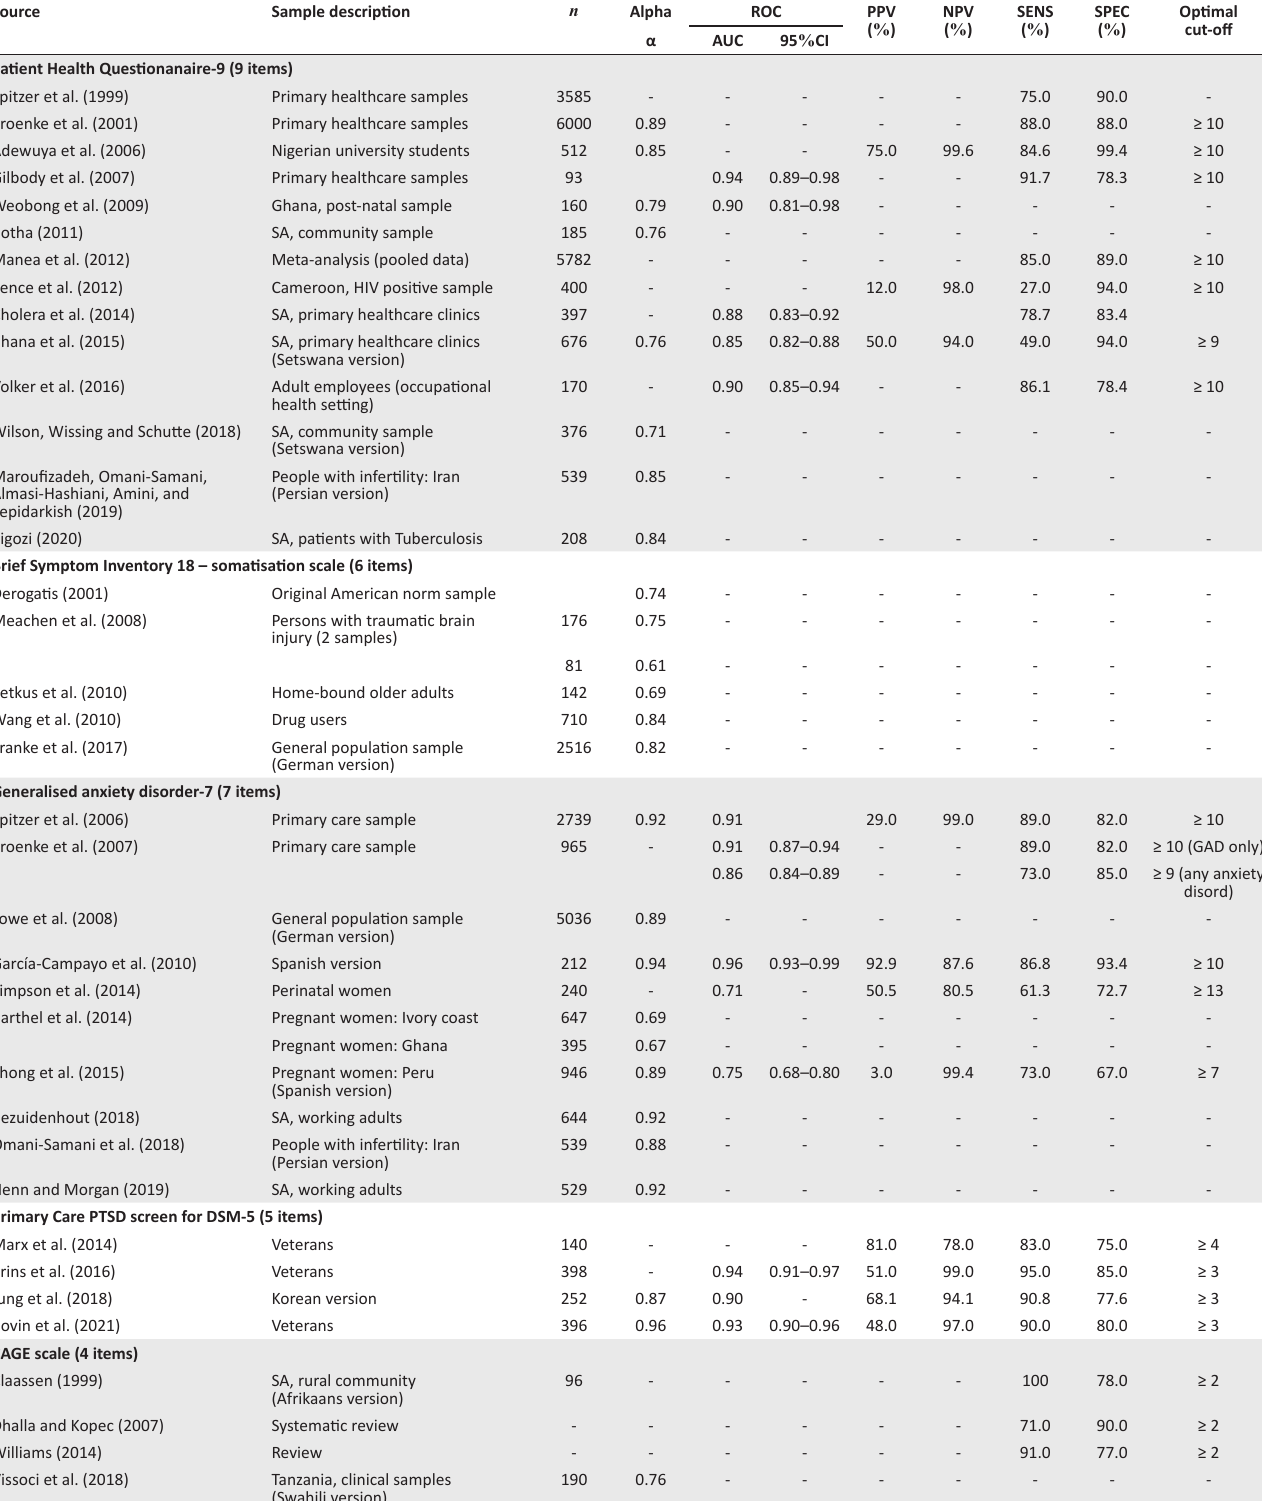
TABLE 2: Overview of internal reliability and diagnostic accuracy data.